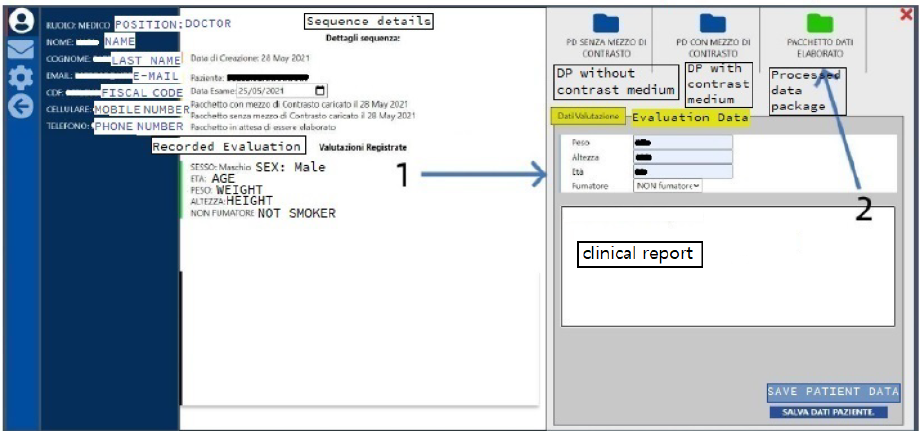
Figure 9. Interface of the doctor user for editing the patient data (1) and accessing the processed data